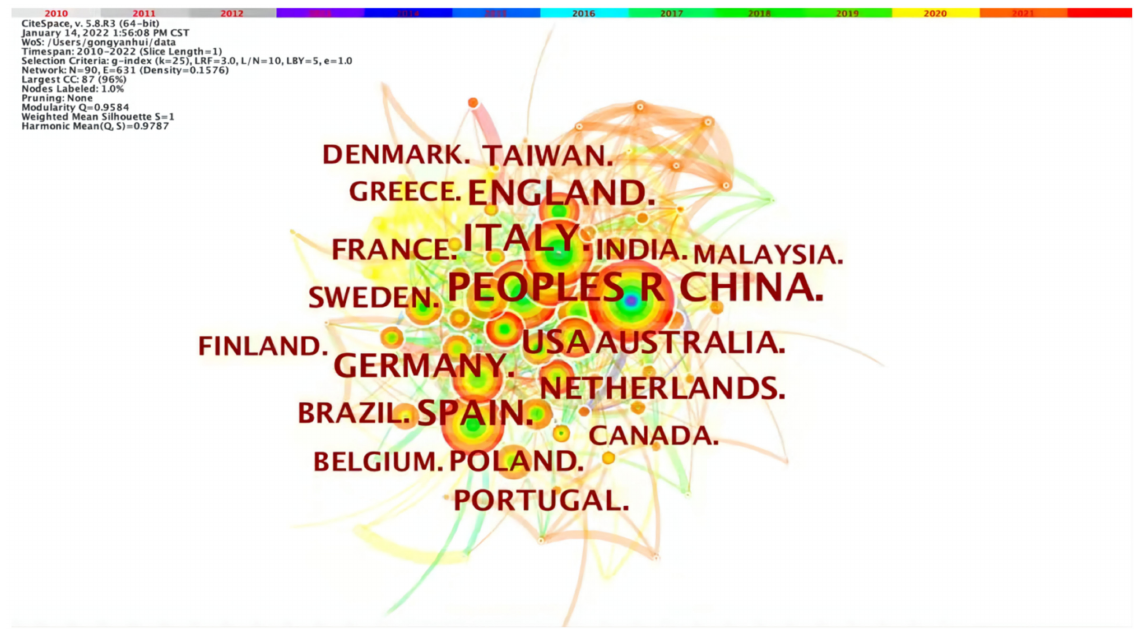
Figure 5. National or regional cooperation